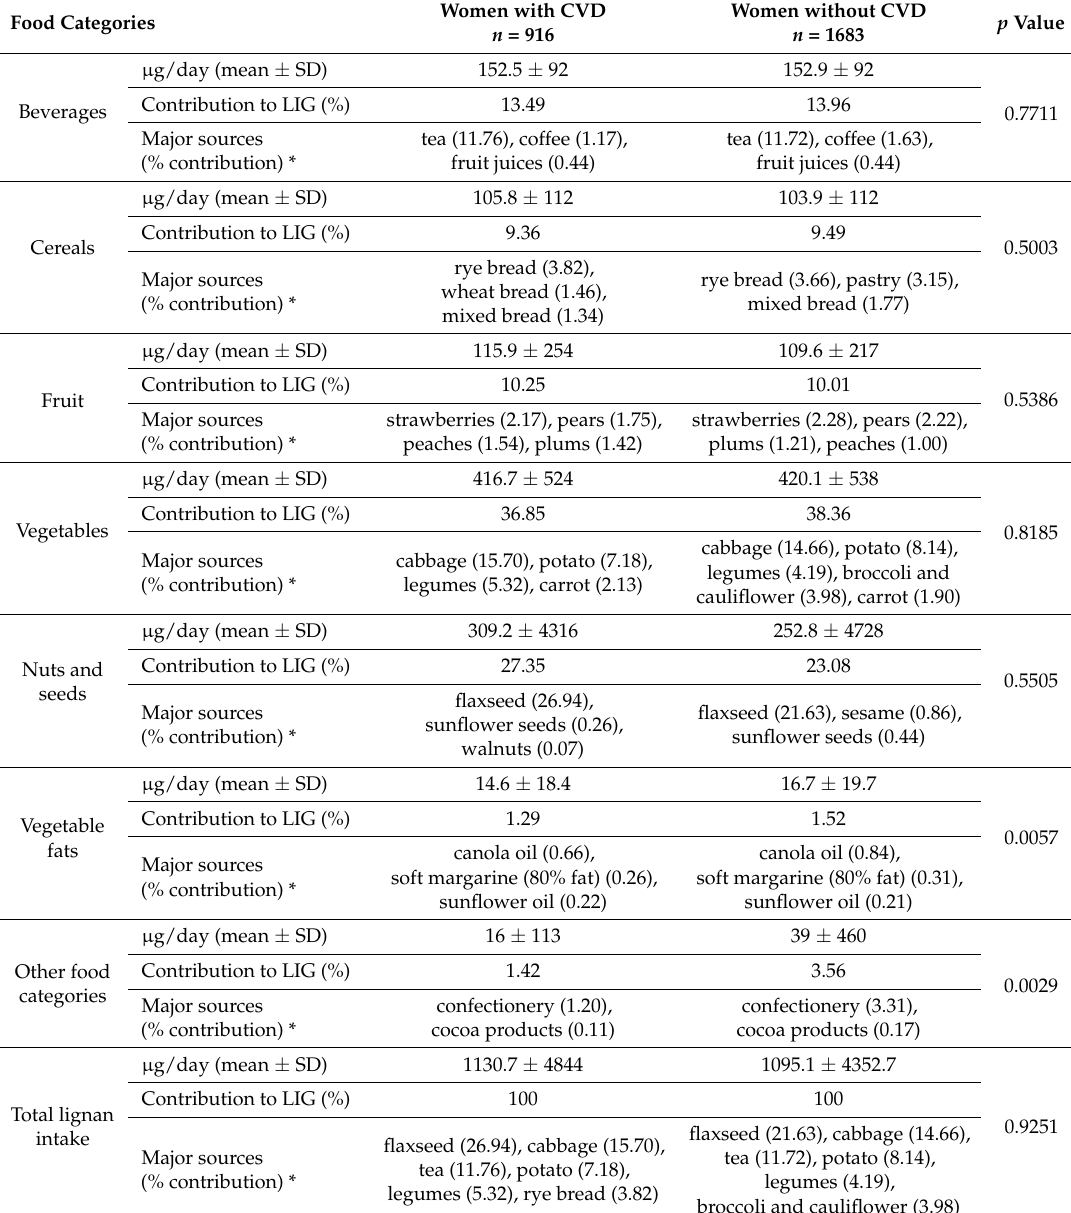
Table 2. Contributions of food categories and individual food products to total lignan (LIG) intake in women with and without